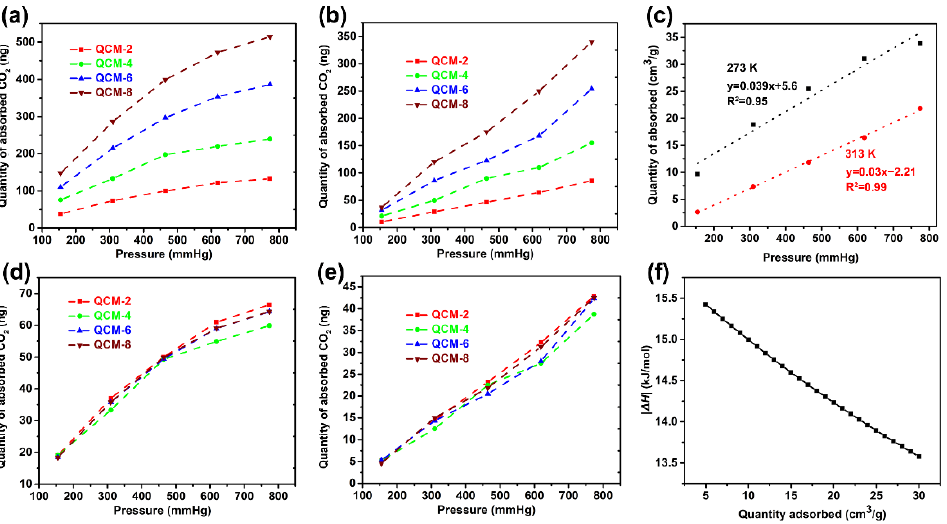
Figure 2. CO 2 absorption curves of the four QCM sensors by the ZIF-8: ( a ) 273 and ( b ) 298 K. Normalized curves of the CO 2 adsorption by the ZIF-8 sensor: ( d ) 273 and ( e ) 298 K. CO 2 adsorption isotherm and ( d ) enthalpy curve for the ZIF-8. ( f ) The relationship between the CO 2 adsorption enthalpy and capacity.